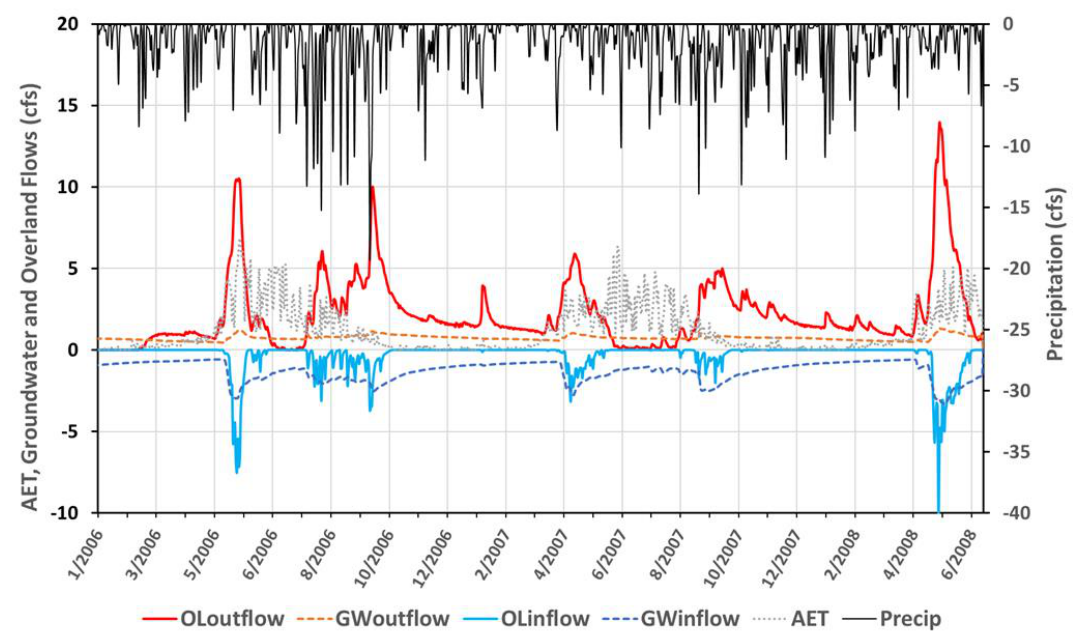
Figure 6. MIKE SHE-simulated pit lake inflows and outflows for the 20-year abandoned pit scenario.